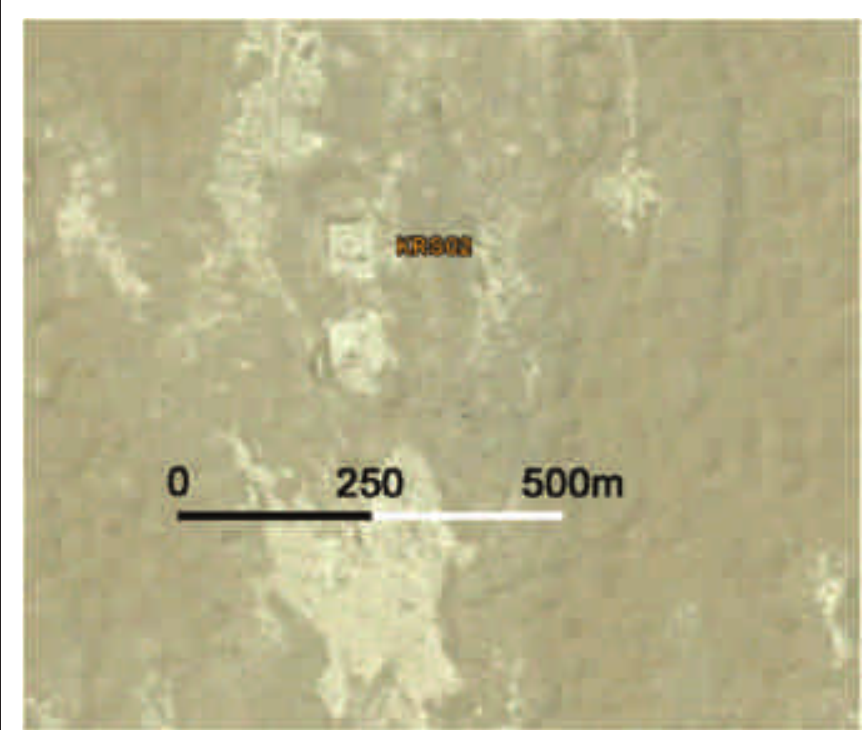
Figure 8 The two caravanserai at location KRS02, clearly visible on the satellite image. (Background © Google EarthTM mapping